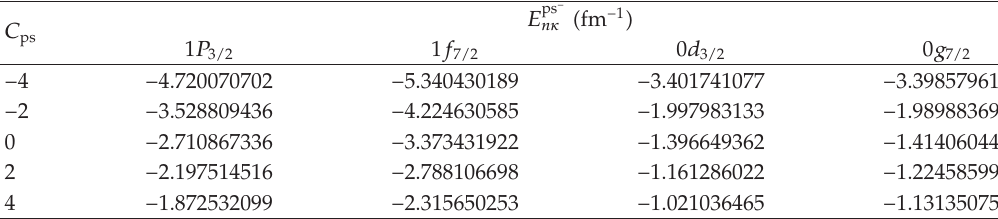
Table 3: Energies in the pseudospin symmetry Limit for A (cid:9) 0 . 5, B (cid:9) 0 . 2, b (cid:9) 1, M (cid:9) 1fm − 1